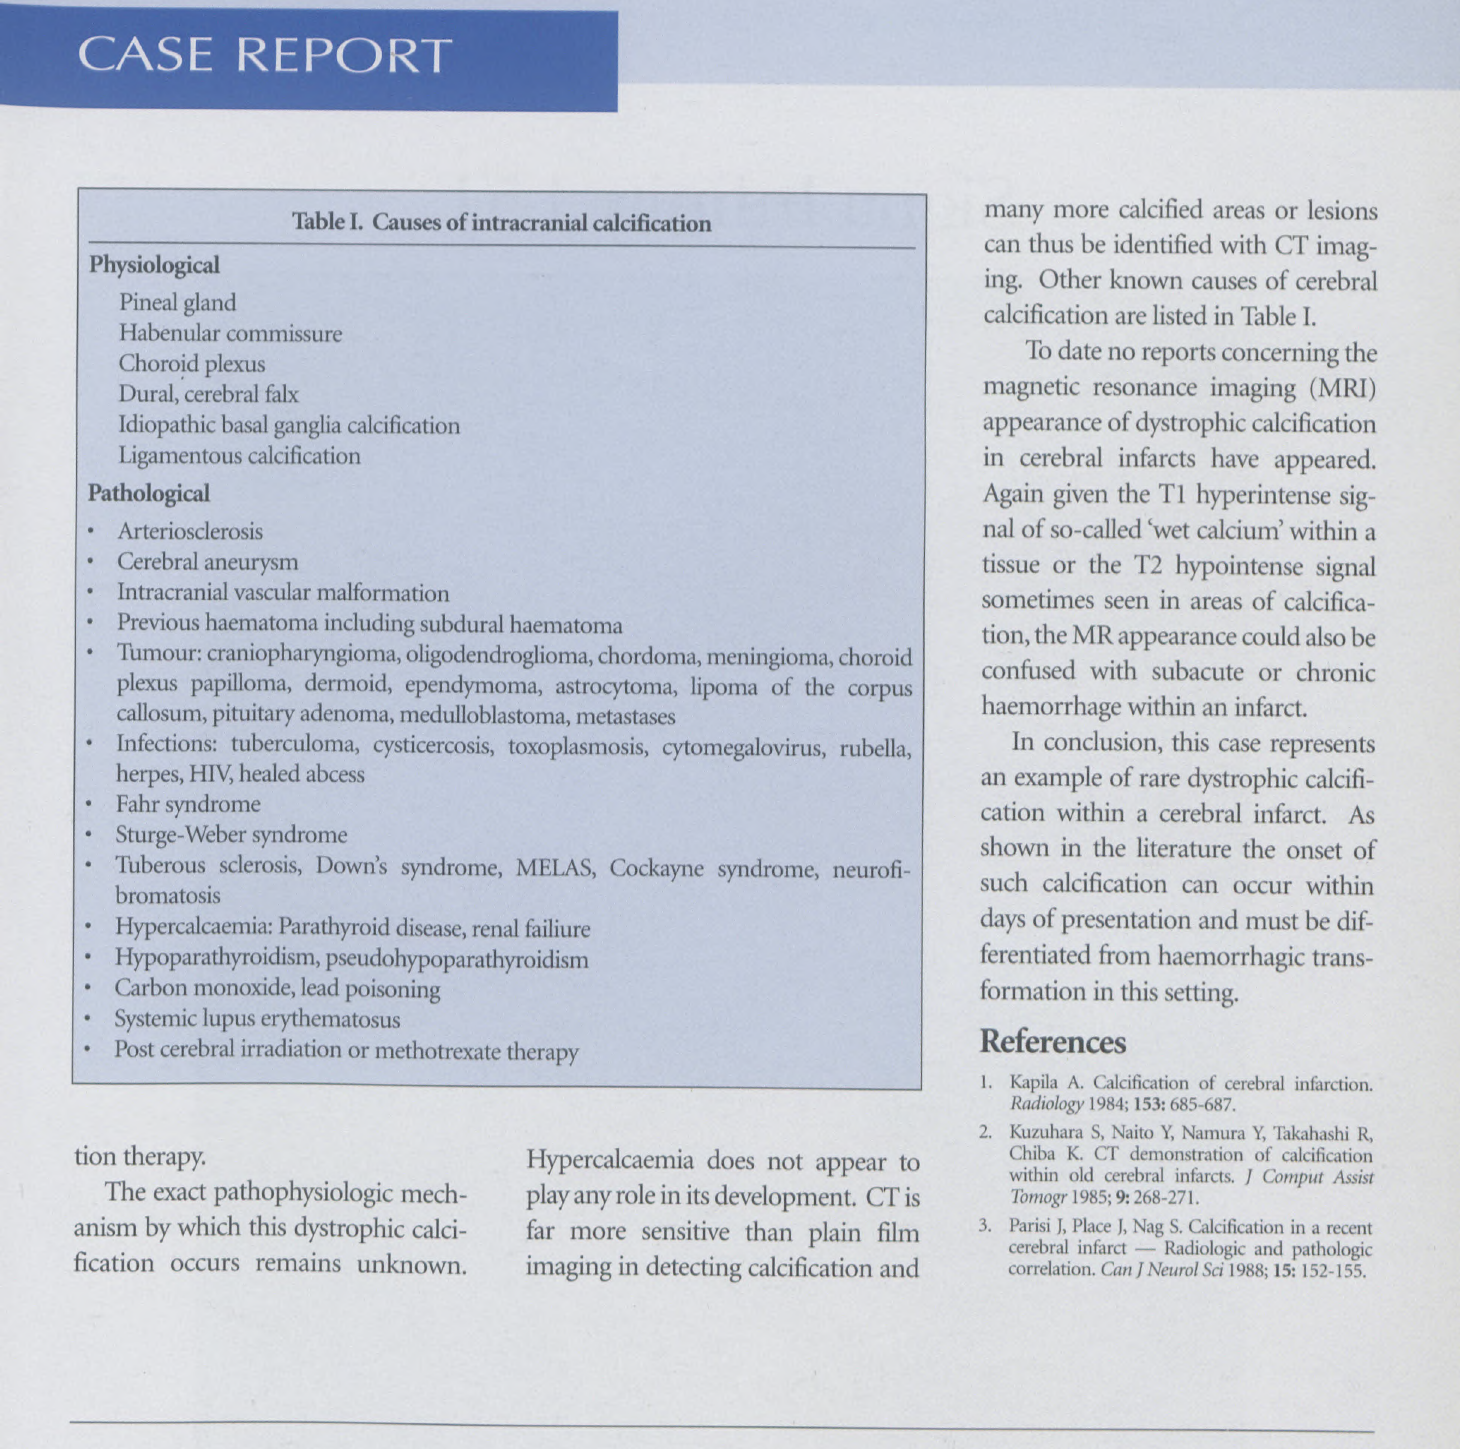
Table I. Causes of intracranial